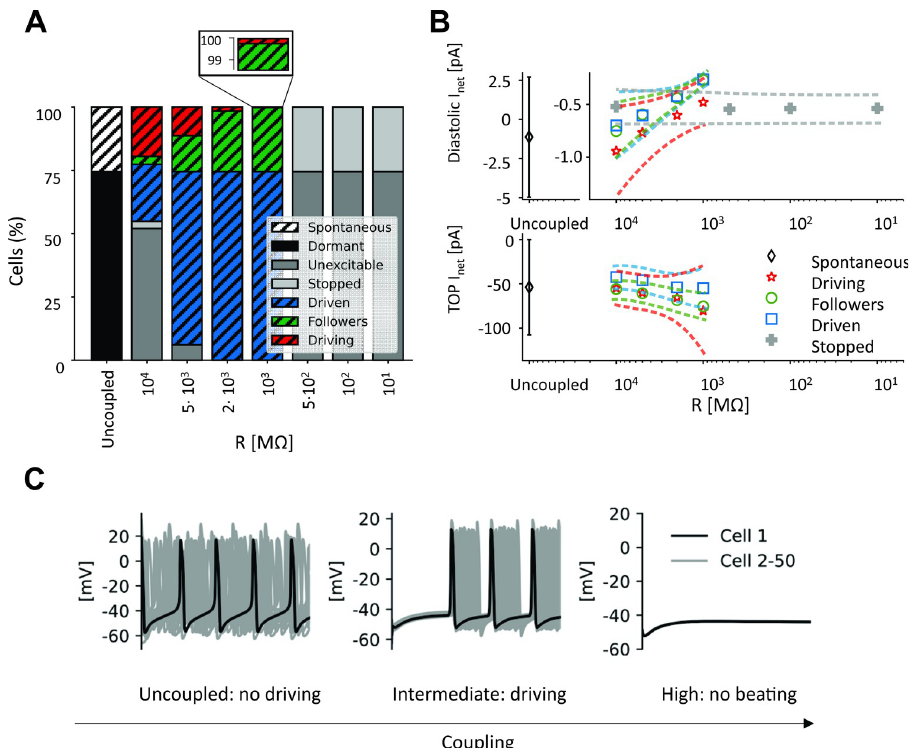
Fig 10. Coupling spontaneous cells with dormant cells inside a tissue. (A) Percentages of cells composing each category at different degrees of intercellular coupling. (B) I net trends during diastole (top) and at TOP (bottom) with respect to different degrees of intercellular coupling for every cell category. Average value (symbol) ± standard deviation (dashed line). (C) Electrical activity of 50 cells (4 th column of the 2D tissue matrix) when they are coupled with different intercellular